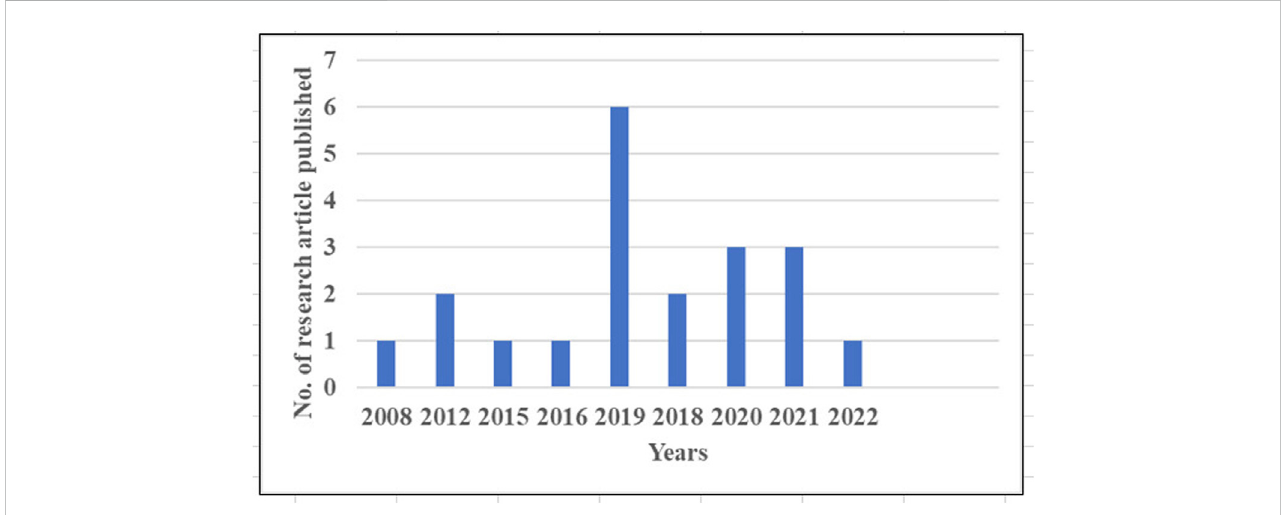
FIGURE 5 Number of research articles published on ethosomes used for treatment skin cancer from 2008 to